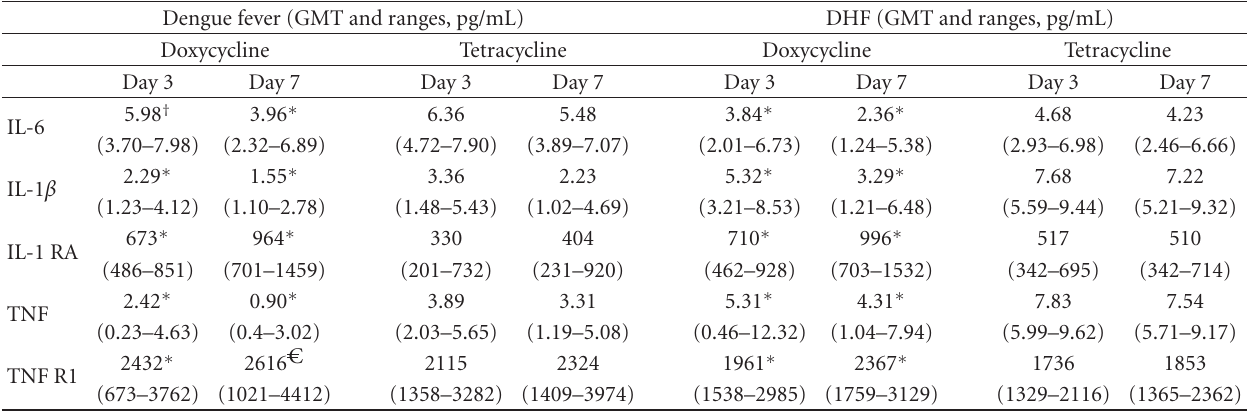
Table 3: Di ff erential e ff ect of Doxycycline and Tetracycline on cytokine levels and IL1-RA and S TNF-R1 in patients with dengue fever and dengue hemorrhagic